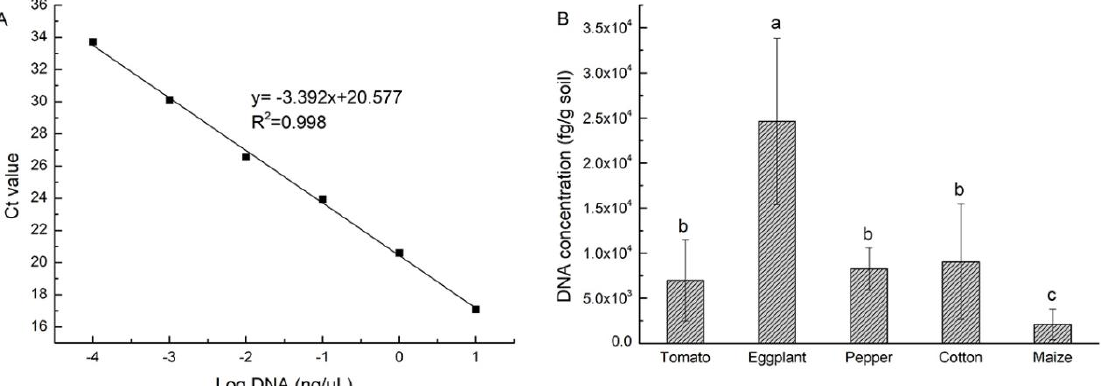
Figure 2. Quantitative detection of Bacillus subtilis strain NCD-2 in rhizosphere of different crops. ( A ) the establishment of standard curves; ( B ) colonization ability of strain NCD-2 in rhizosphere soil of different crops. Bars with the same lowercase letters indicate no significant difference between treatments based on one-way analysis of variance (ANOVA) ( p < 0.05).